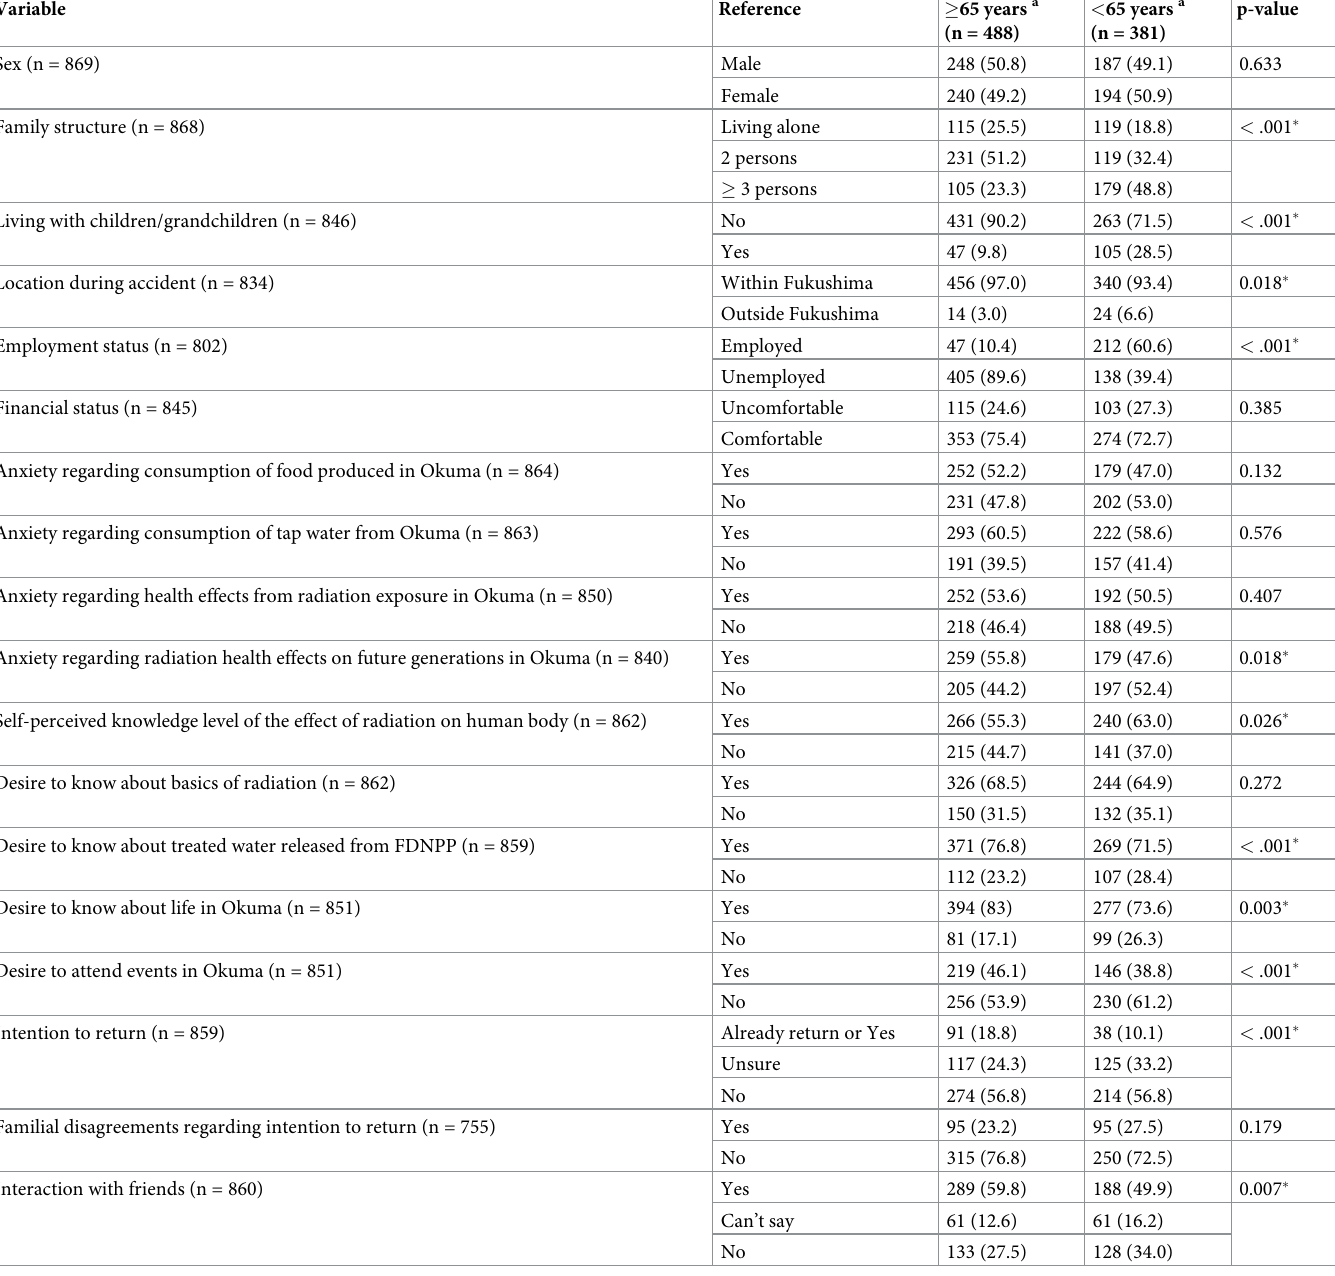
Table 1. Demographic characteristics, intention to return, anxiety, and desire to know about